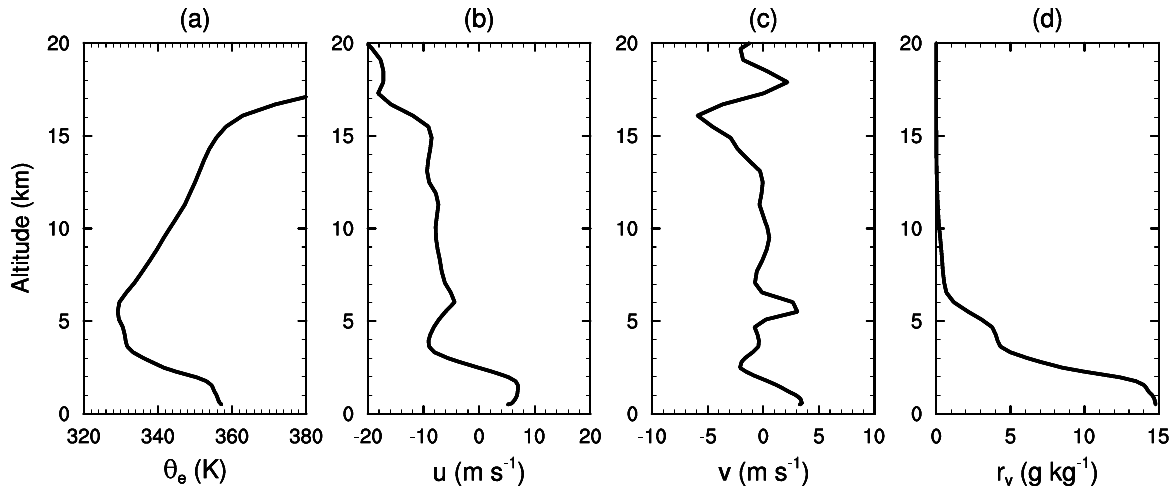
Fig. 3. (a) Equivalent potential temperature ( θ e in K), (b) zonal ( u in ms − 1 ) and (b) meridional wind ( v in ms − 1 ), and (d) water vapor mixing ratio ( r v in gkg − 1 ) profiles at 12:00UTC 15 August 2004 averaged over the model-3 domain, prior to the triggering of the MCS.